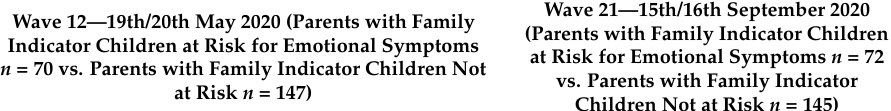
Table 3. Multivariate logistic regression—relative frequencies and odds ratios of parents with children and adolescents at risk for emotional